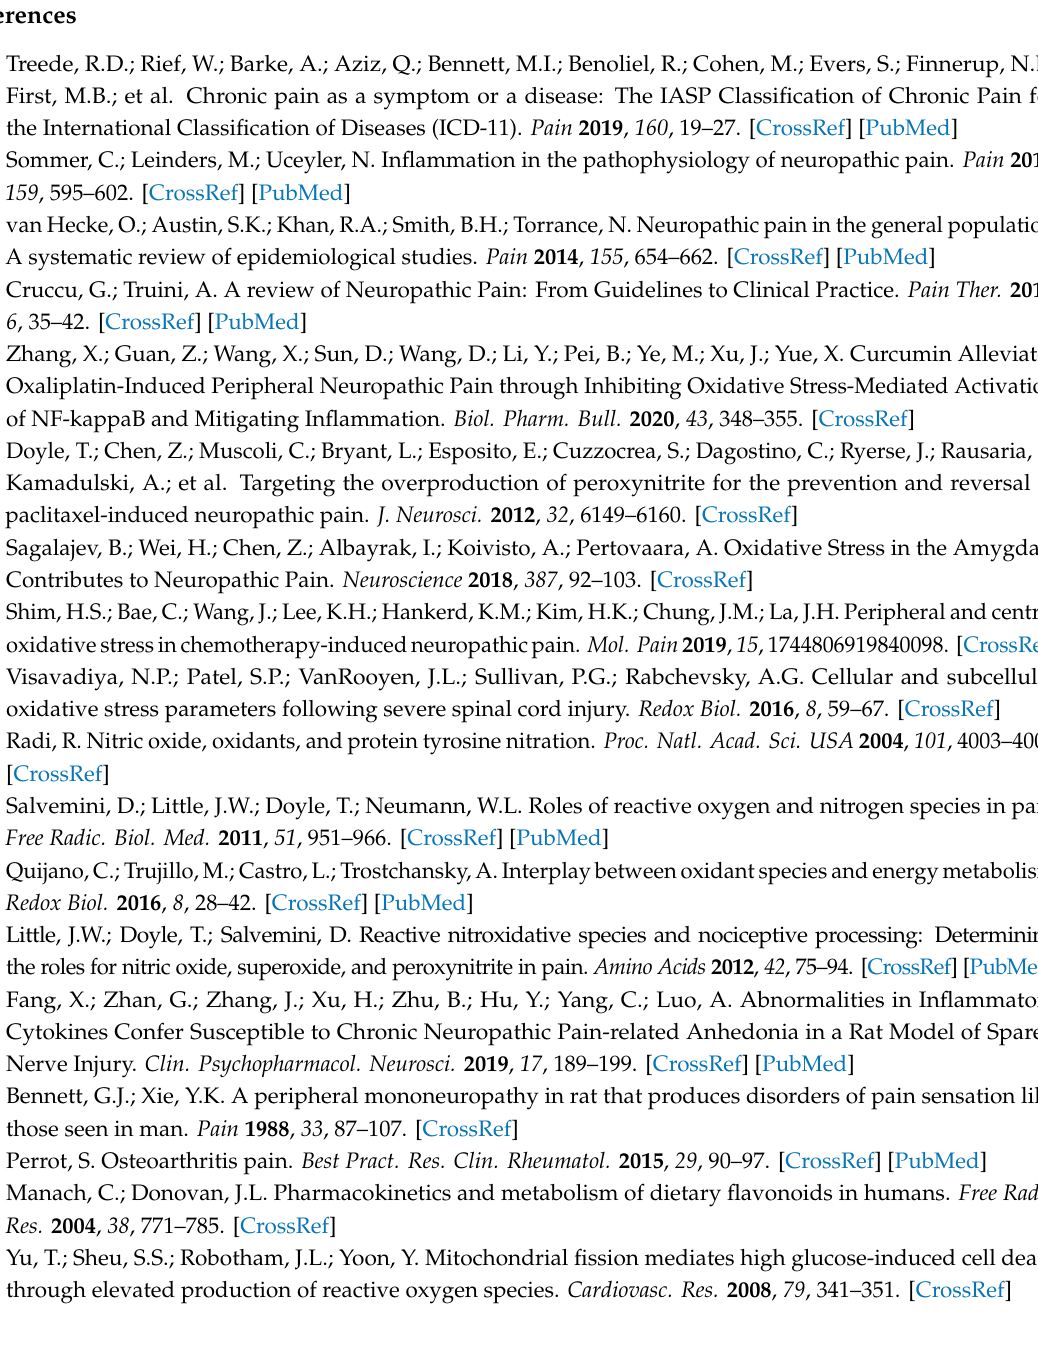
Figure S1. E ff ects of treatment with BPF or pregabalin on allodynia and hyperalgesia after inducing CCI in rats, Figure S2. The development of hyperalgesia and allodynia coincided with an increase of 4-HNE levels either 14- or 21-days post injury, Figure S3. The inhibition of SIRT3 induces acetylation on mitochondrial proteins either 14- or 21-days post